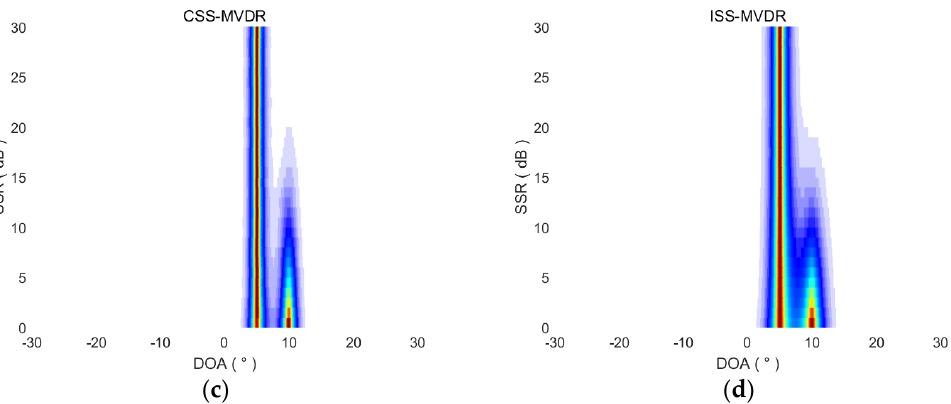
Figure 6. DOA estimation results of CSS-CS, ISS-CS, CSS-MVDR and ISS-MVDR in terms of SSRs. ( a ) DOA estimation results of CSS-CS in terms of SSRs; ( b ) DOA estimation results of ISS-CS in terms of SSRs; ( c ) DOA estimation results of CSS-MVDR in terms of SSRs; ( d ) DOA estimation results of ISS-MVDR in terms of SSRs.